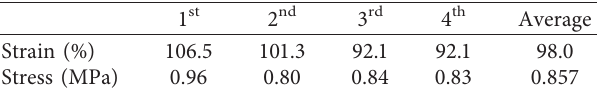
2 permeability; (b) calcium ion permeability; (c) water vapor permeability; (d) Table 1: Strain and stress of sealing